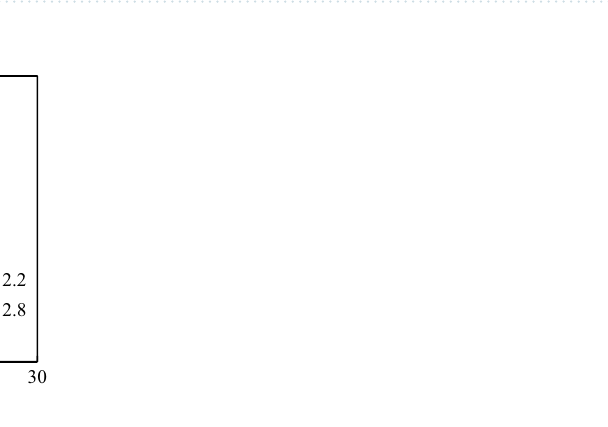
Figure 17. Relationship between the tensile strength of the pavement composite structure and transverse crack spacing.